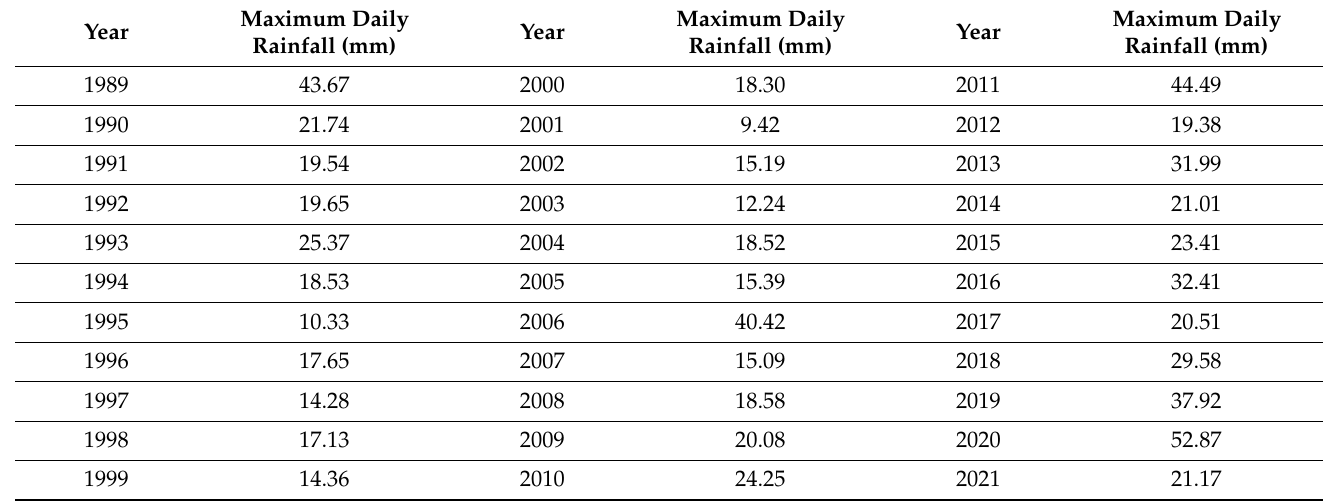
Table 3. Precipitation depths (mm) as a function of return periods. Design Rainfall Depth for Different Recurring Times Statistical Distribution